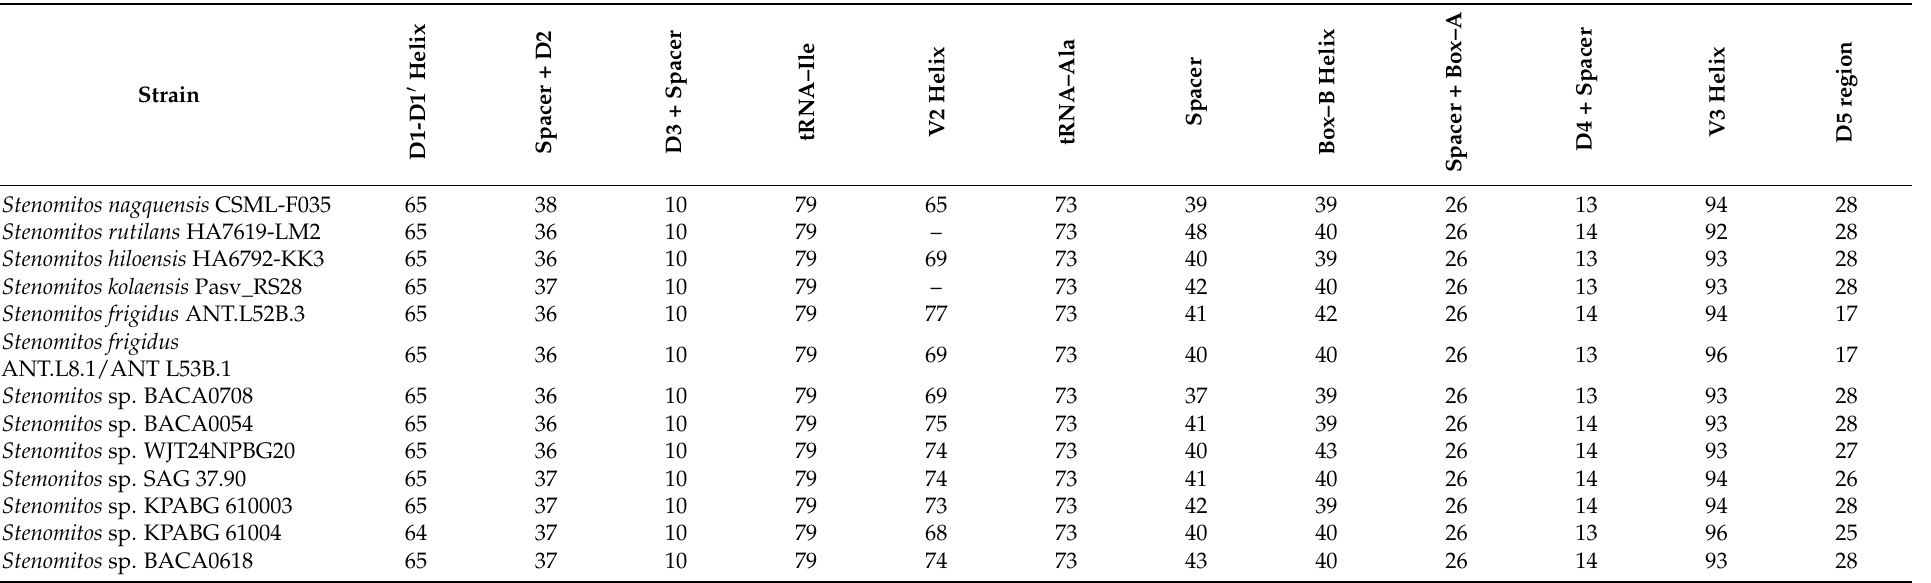
Table 2. Lengths of conserved domains of the 16S–23S rRNA ITS region among Stenomitos nagquensis sp. nov. and its closely related strains.